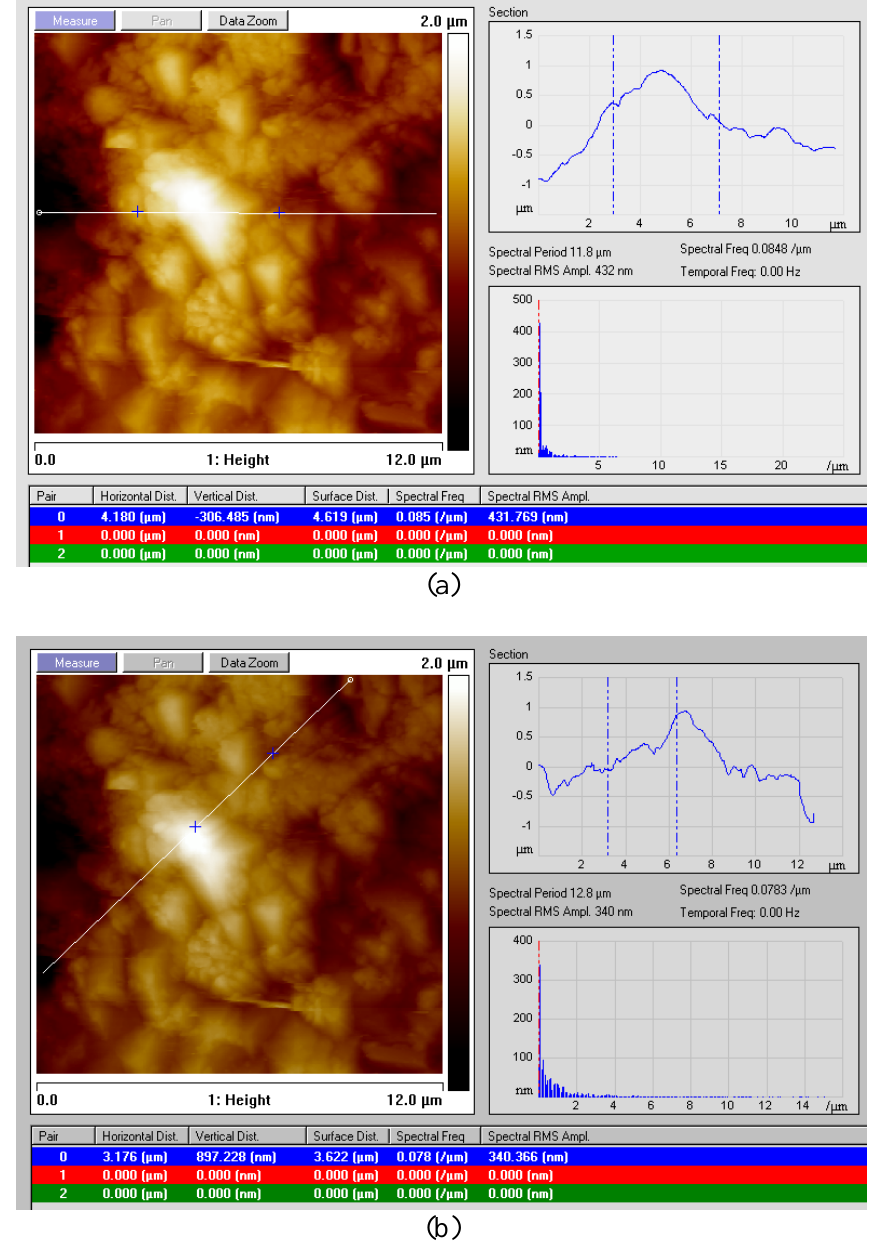
Figure 12. Section surface analysis of GC415 coated carbide inserts indicating the configuration of the coating